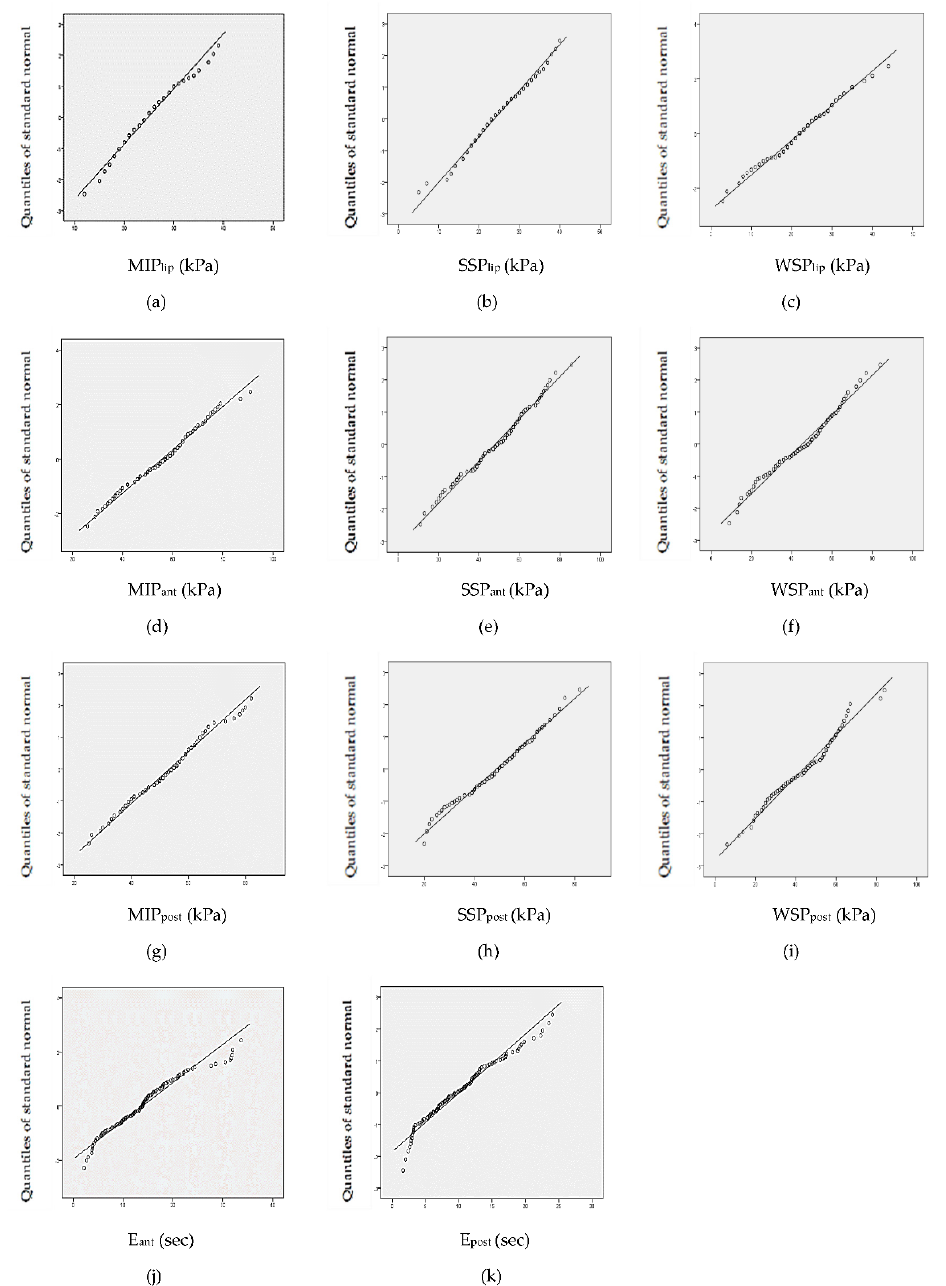
Figure A1. Quantile-quantile (Q-Q) plots of the dependent variables. The 95% confidence intervals are indicated by the dotted lines. ( a ) Q-Q plot of MIP lip ; ( b ) Q-Q plot of SSP lip ; ( c ) Q-Q plot of WSP lip ; ( d ) Q-Q plot of MIP ant ; ( e ) Q-Q plot of SSP ant ; ( f ) Q-Q plot of WSP ant ; ( g ) Q-Q plot of MIP post ; ( h ) Q-Q plot of SSP post ; ( i ) Q-Q plot of WSP post ; ( j ) Q-Q plot of E ant ; ( k ) Q-Q plot of E post .